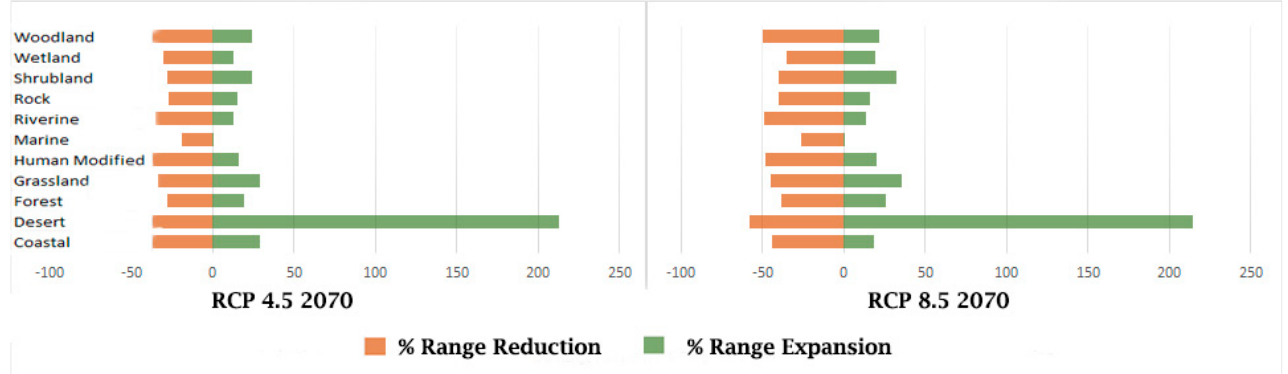
Figure 2. Habitat–wise % changes in distribution ranges of bird species in 2070 under RCP 4.5 and RCP 8.5 scenarios in India.